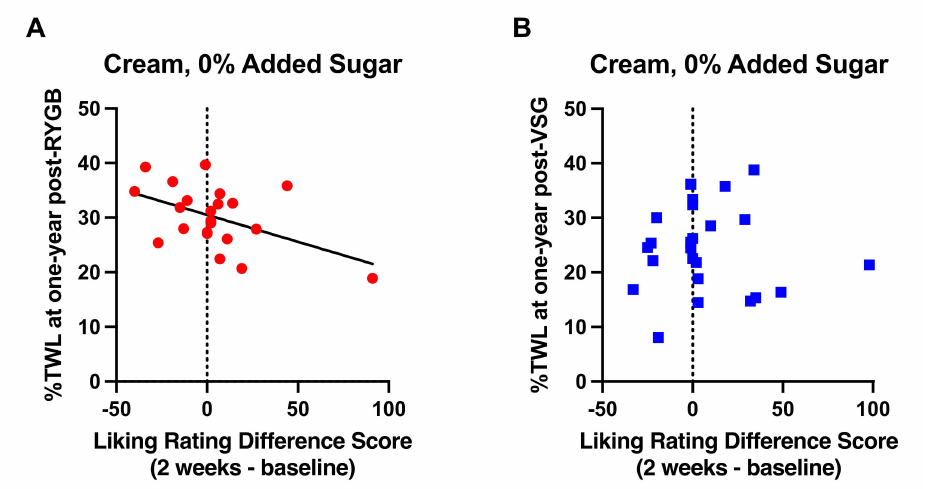
Figure 5. Relationship of difference scores demonstrating changes in liking ratings for cream with no added sucrose at 2 weeks after surgery from baseline with %TWL at one year in patients who received ( A ) RYGB (red circles) and ( B ) VSG (blue squares). Line of best fit represents significant